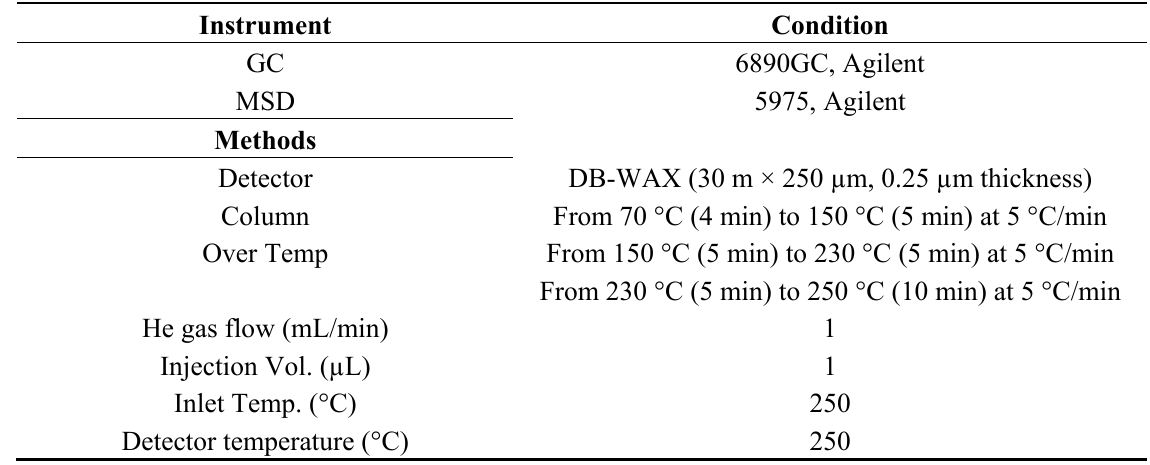
Table 2. Operation conditions of GC-MS analysis used in this